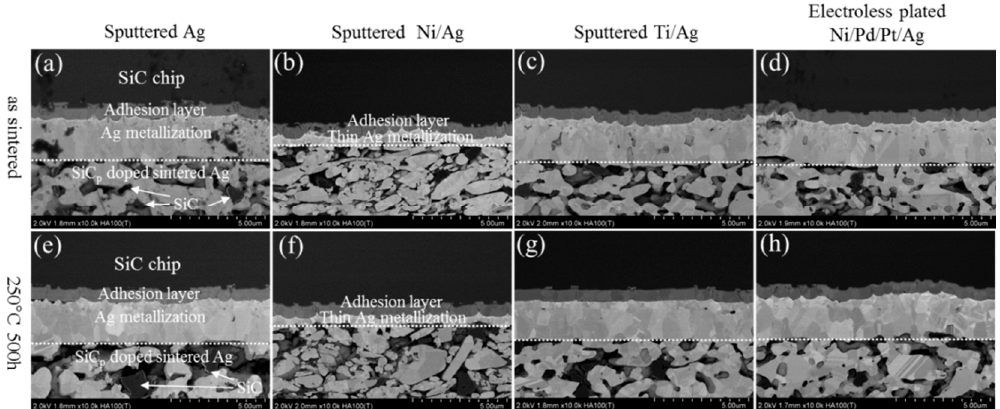
Figure 4. Evolution of SiC p doped Ag sintered joint at the chip sides in as-sintered state and after HTS for 500 h: ( a – d ) as sintered state, ( e – h ) after HST for 500 h.